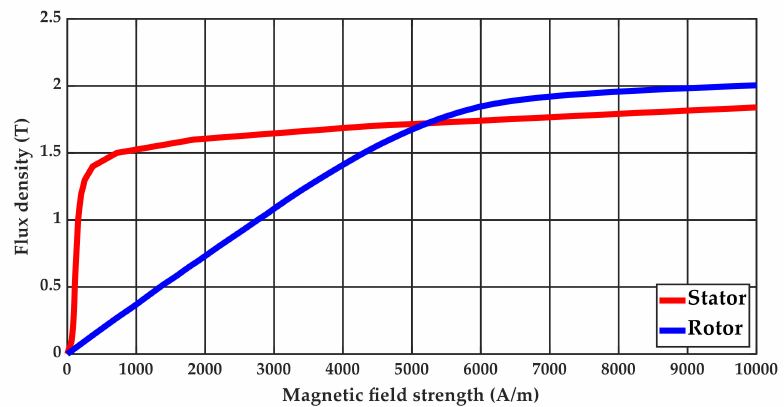
Figure 2. DC magnetization curves used in